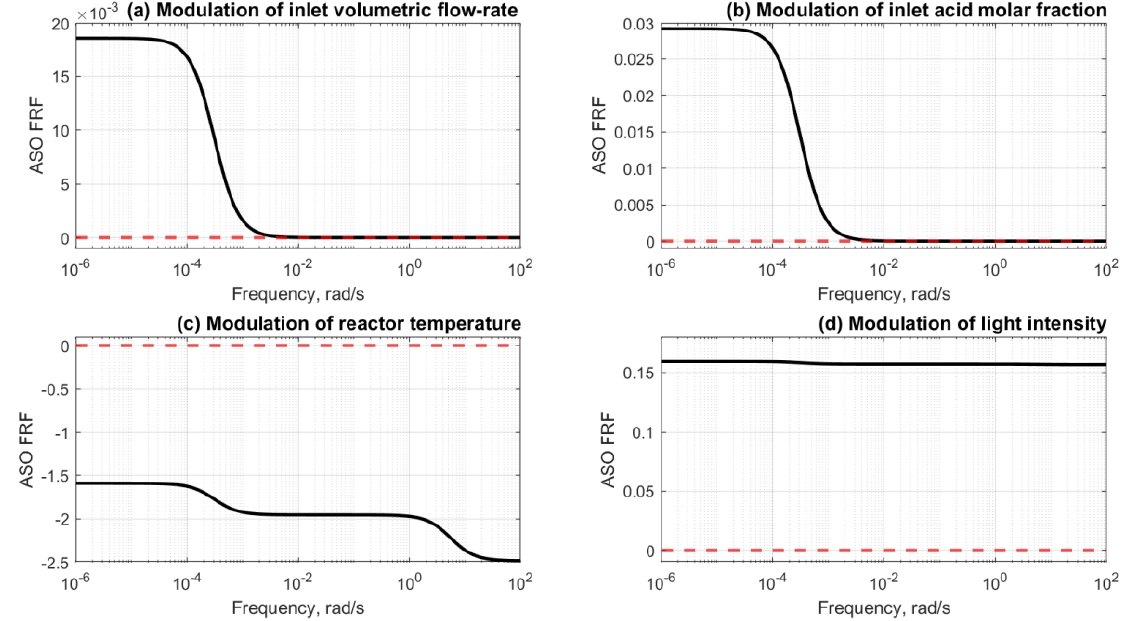
Figure 3. Asymmetrical second order frequency response functions for single input modulations of ( a ) Inlet volumetric flowrate; ( b ) Inlet acid molar fraction; ( c ) Reactor temperature; ( d ) Light intensity, for steady-state point SS5.